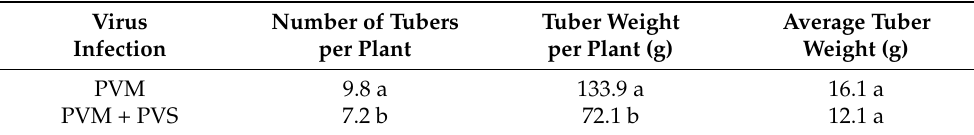
Table 9. Tuber yield components of R1 clones produced from minitubers, as affected by the sanitary status of the